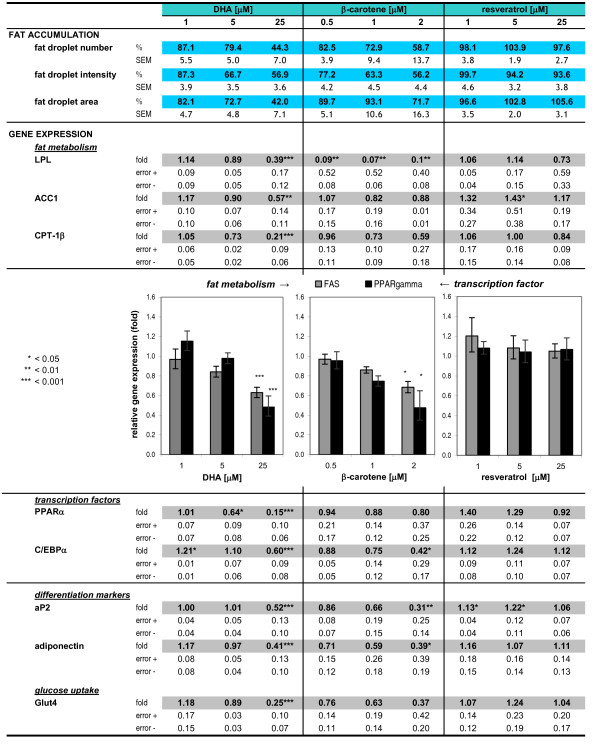
Summary of overall effects of the dietary ingredients DHA, β-carotene and resveratrol on lipid accumulation and on gene expression clusters. mRNA levels of enzymes involved in glucose and fat metabolism (Glut4, LPL, FAS, ACC1 and CPT-1β) and of adipocyte differentiation markers (PPARγ, C/EBPα, PPARα, aP2 and adiponectin) were determined in maturing C3H10 T1/2 cells. Depicted are the dose-dependent effects of DHA and β-carotene and the impact of resveratrol on lipid accumulation (after 7 days treatment, top of the table) and on gene expression (after 4 days treatment) relative to rosiglitazone control cells. Data are shown as % of positive control ± SEM (fat accumulation parameters) and fold change ± error (based on SEM, n = 6 - 15) for gene expression levels, respectively. Exemplarily, the fold changes of the genes FAS and PPARγ are shown as illustration. Fat droplet number equates to Spot Count/Object; fat droplet intensity equates to Spot Avg Intensity and fat droplet area equates to Spot Total Area/Object. Student's t-test: treatment versus control (*) p < 0.05, (**) p < 0.01, (***) p < 0.001. The average coefficient of variation (CV) for dCT values was less than 5% for all analysed genes at all concentration of the investigated compounds.